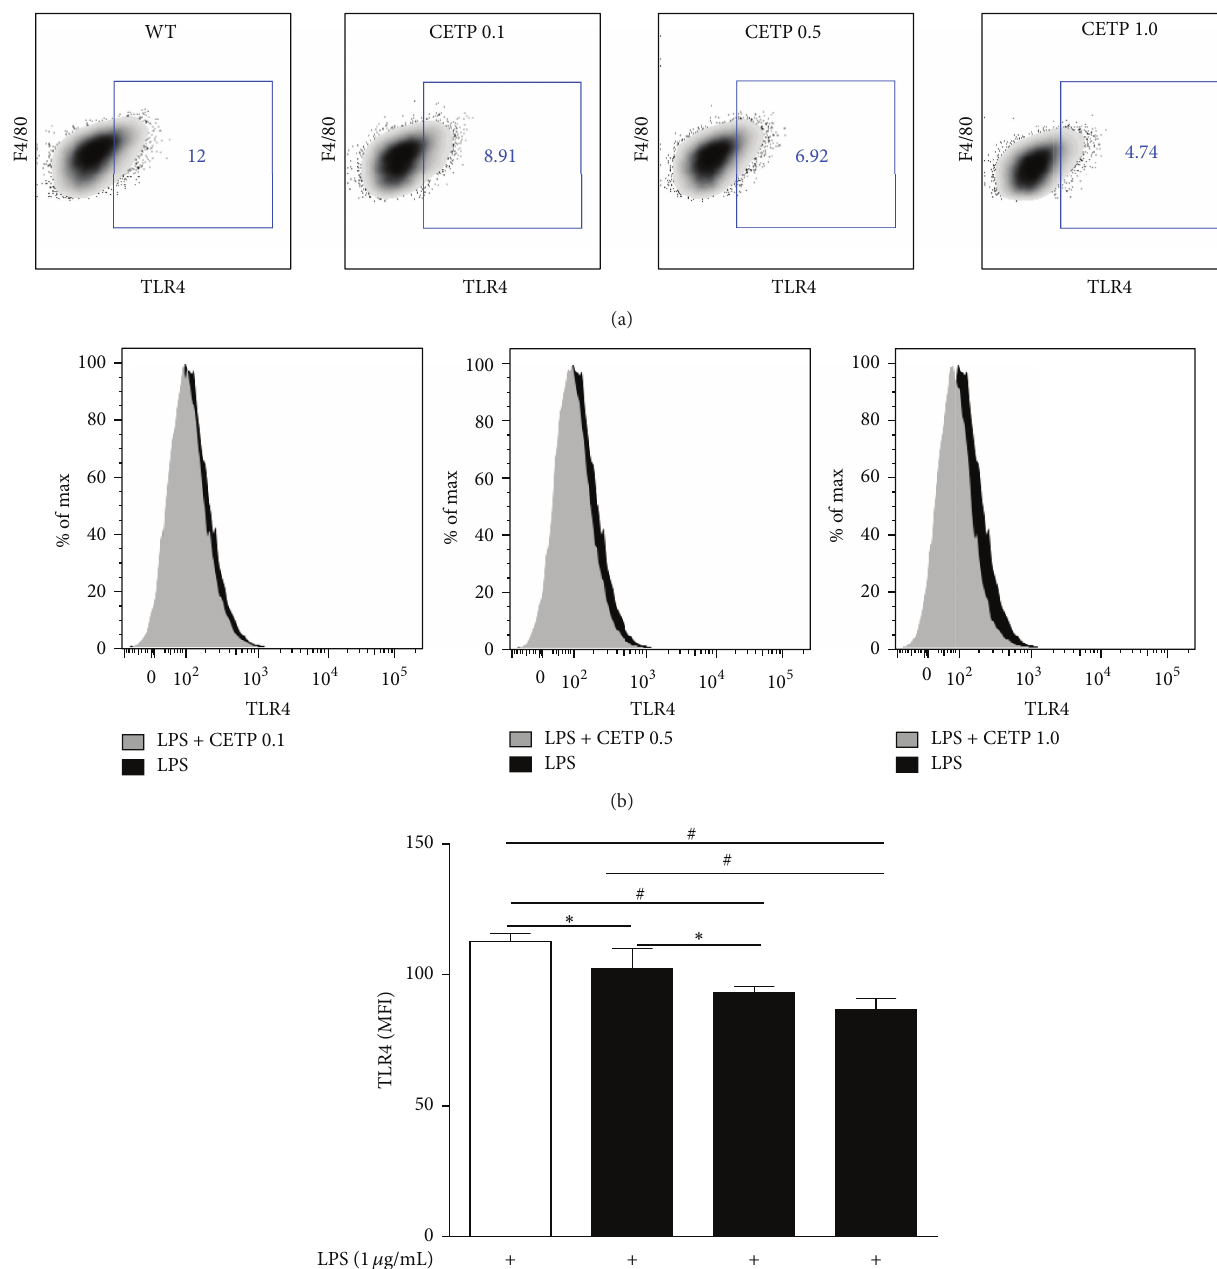
Figure 6: CETP reduces TLR4 expression in LPS-stimulated macrophages. Peritoneal macrophages obtained from WT mice were stimulated for 24 h with LPS-Alexa Fluor 488 (1 𝜇 g/mL) in the absence or presence of CETP (0.1, 0.5, and 1.0 𝜇 g/mL). (a) Representative FACS dot plots gated on F4/80 + cells (macrophages only) and the percentage of TLR4 + cells are shown. (b) Representative flow cytometry histograms of TLR4 comparing macrophages (F4/80 + ) from WT and respective CETP groups stimulated with LPS. (c) Graph presented as mean ± SD of MFI (median fluorescence intensity) analyzed using FACSDiva software ( 𝑛 = 4 ), representative of three independent experiments, by one-way ANOVA 𝑝 = 0.0014 and posttest (Newman-Keuls Multiple Comparison Test; ∗ 𝑝 < 0.05 and # 𝑝 < 0.01